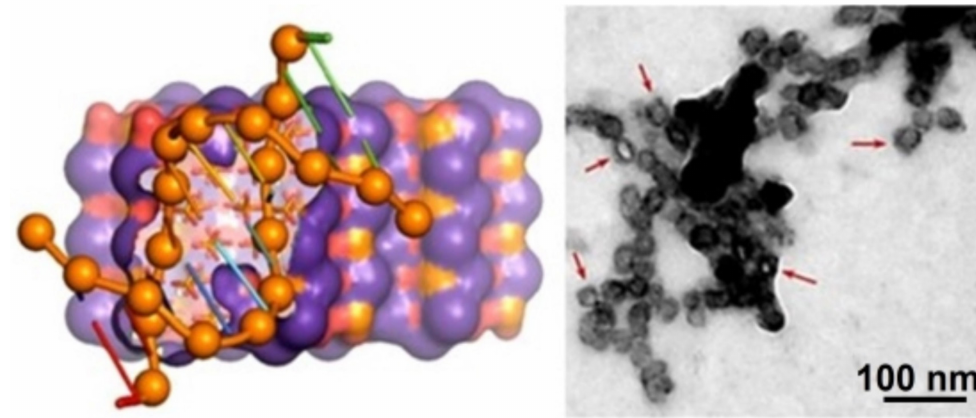
Figure 7. Scheme showing the incorporation of DNA inside the HAp structure ( left ) and TEM micrograph showing nanoparticles (red arrows) that incorporate DNA ( right ). Reproduced with permission from [64,65],